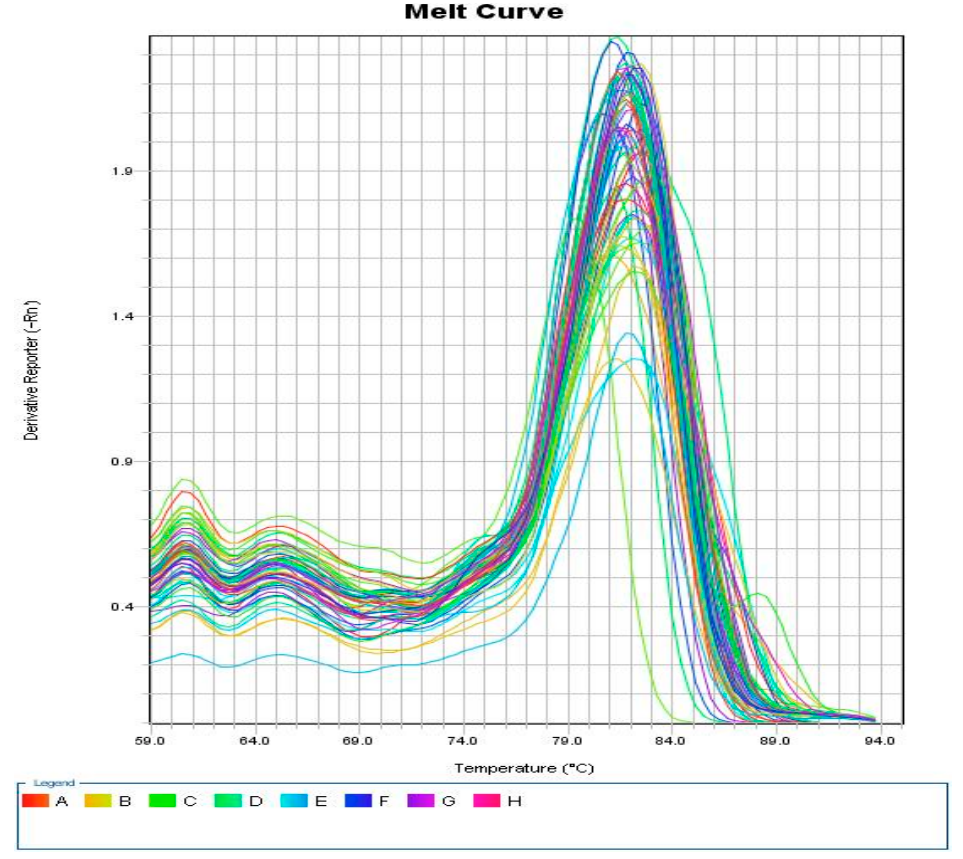
Figure 2. c-myc melt curve generated by 7500 ABI system for confirmation of c-myc product am-